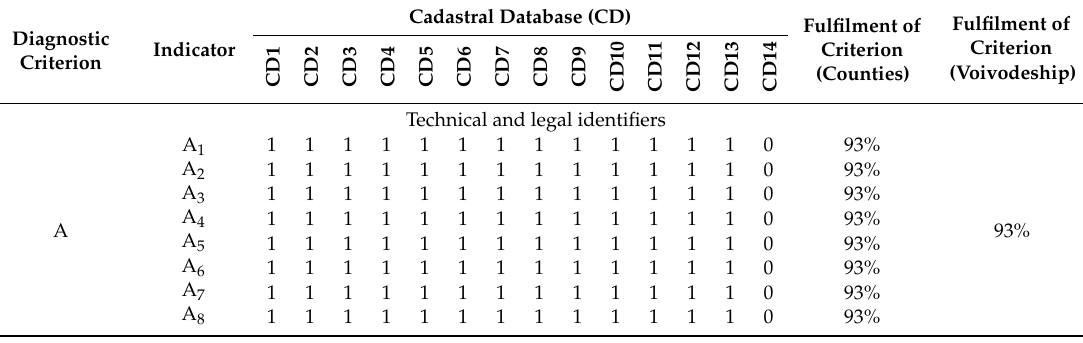
Table 9. Evaluation of Cadastral Databases Based on Criterion A.